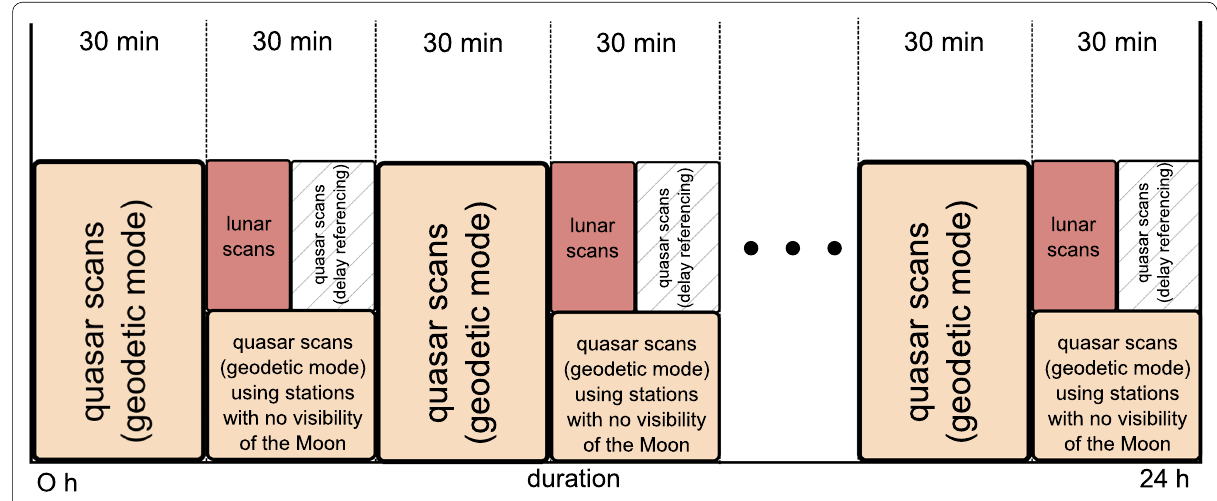
Fig. 1 Combination of quasar and lunar observations in the OCEL sessions. The delay-referencing scans are not part of this